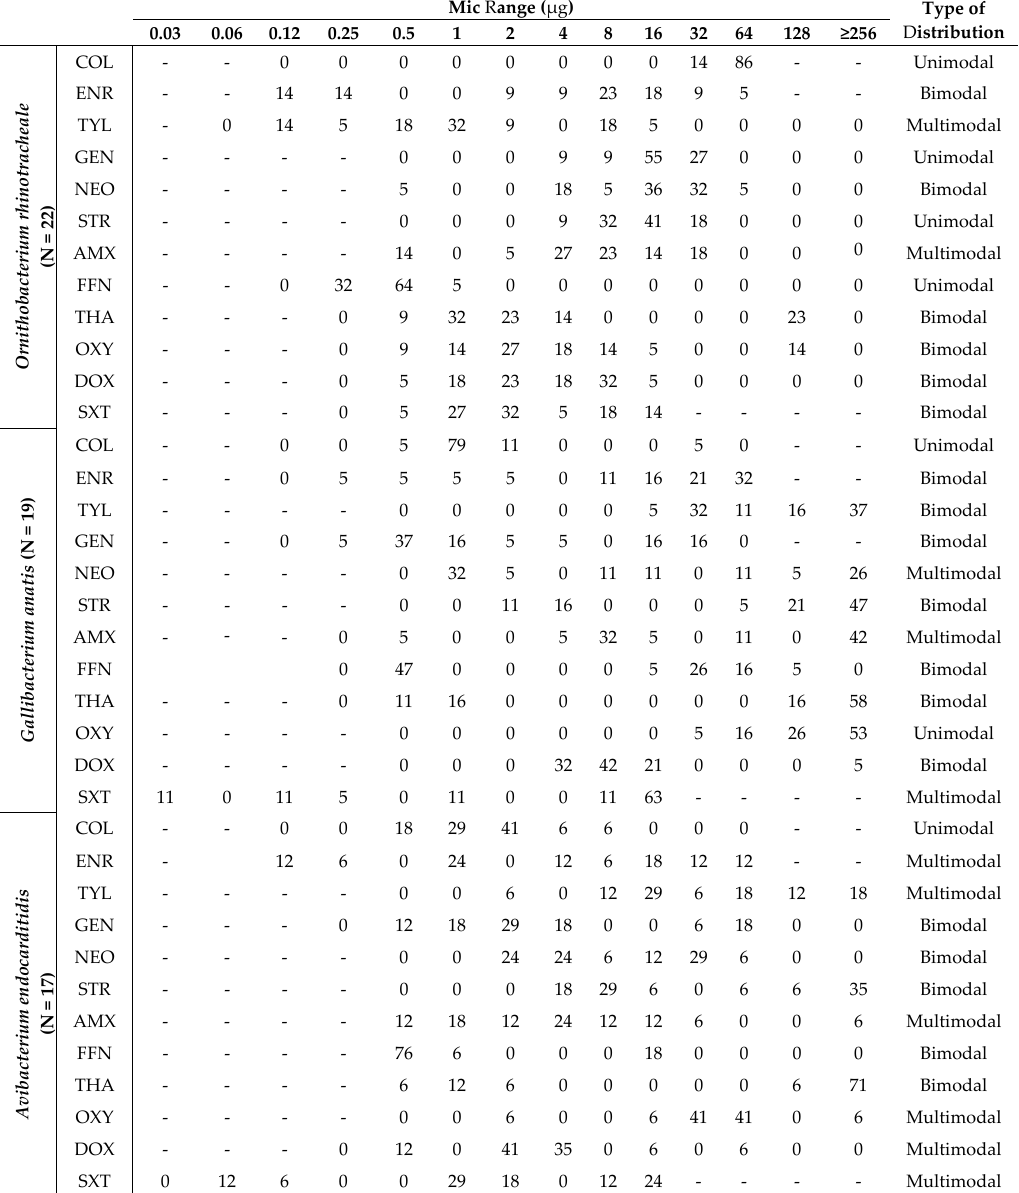
Table 1. Distribution of minimal inhibitory concentrations (MICs) of 12 antimicrobials commonly used for three chicken pathogens from the Mekong Delta of Vietnam. Antibiotics 2020 , 9 , x FOR PEER